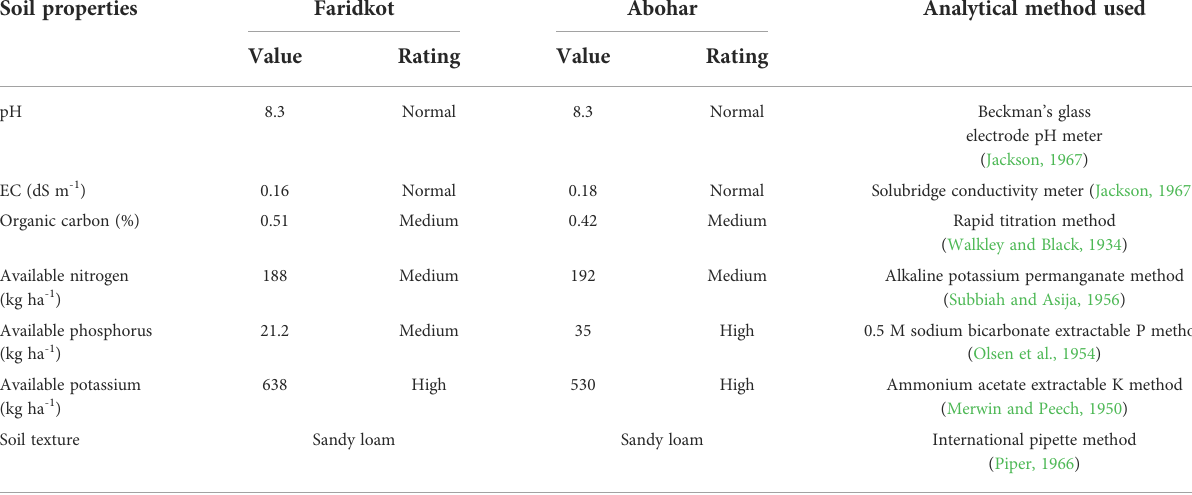
TABLE 1 Chemical properties of soil at the experimental sites.